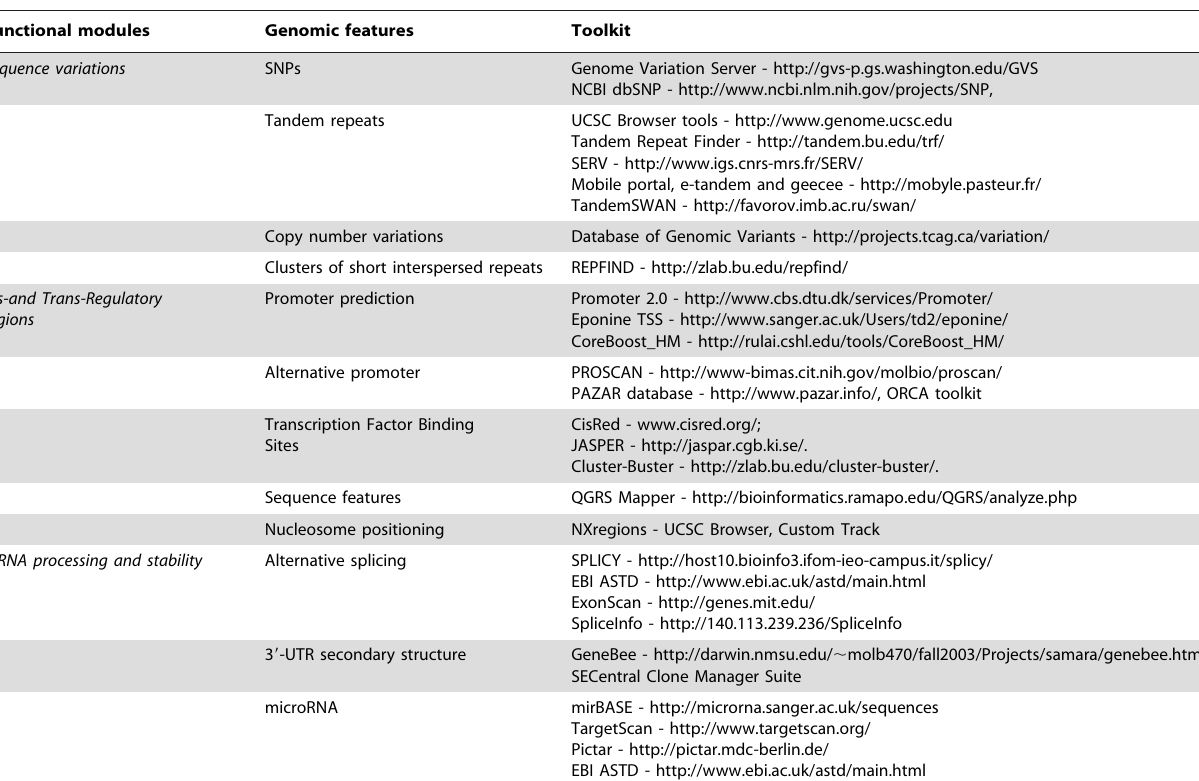
Table 1. Databases and Computational tools used for the analysis.